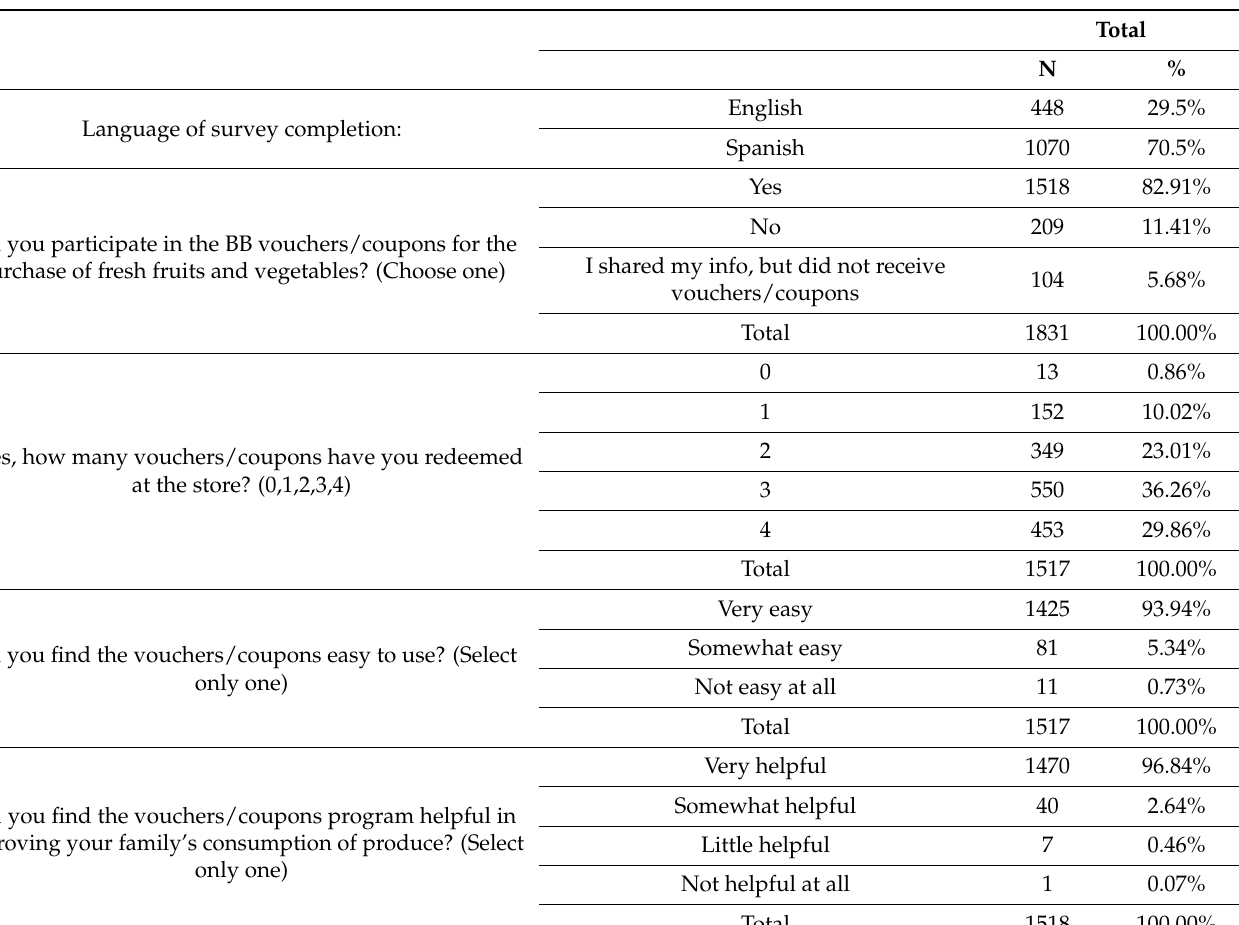
Table 2. Voucher satisfaction and utilization from Brighter Bites families participating in the produce voucher program, Brighter Bites process evaluation survey July 2020 (n =